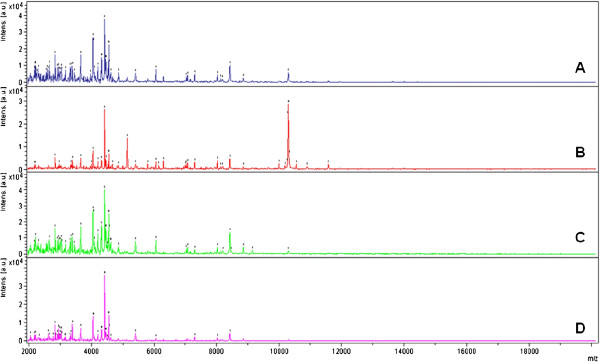
Comparison of mass spectra obtained from four subcultures of a strain of Aspergillus flavus. The Aspergillus flavus 1027804 strain was subcultured on four different agar plates. Spectra A, B, C, and D display the first spectrum acquired from the subcultures 1, 2, 3 and 4, respectively. Spectra A to D display many common peaks; however, a few varying peaks are also clearly visible and characteristic of one of the subcultures.